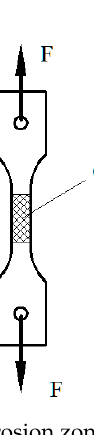
Figure 2. Schematic showing corrosion zone on the test specimen and nature of loading.